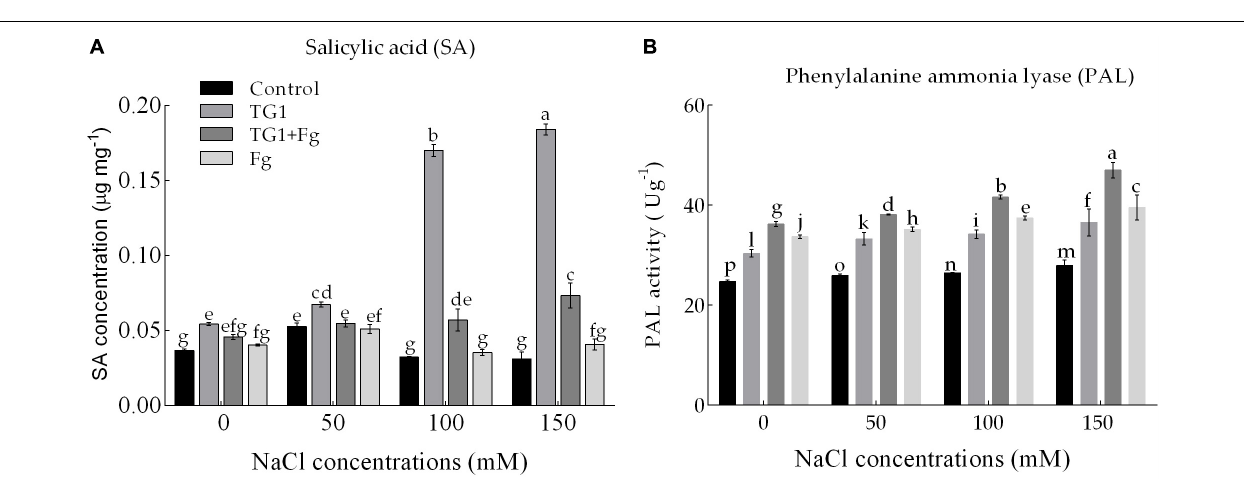
FIGURE 7 | Effect of T. longibrachiatum (TG1) on (A) salicylic acid content and (B) phenylalanine ammonia-lyase (PAL) activity of wheat seedlings subjected to F. pseudograminearum (Fg) and different salinity stress at 28 days after inoculation. Small bars represent the standard errors of the means. Different lower case letters indicate significant differences at P < 0.05 in Duncan’s multiple range test using two-way ANOVA. Treatments are detailed in the footnote of Figure 5